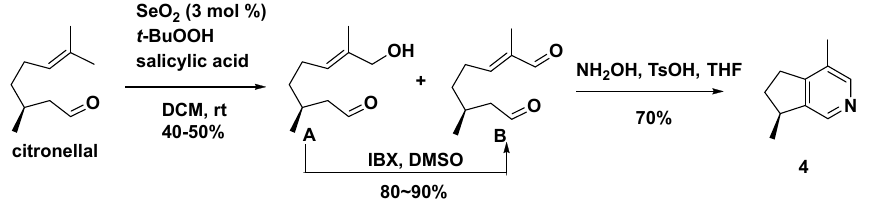
Scheme 14. Diastereoselective synthesis of actinidine ( 4 ).